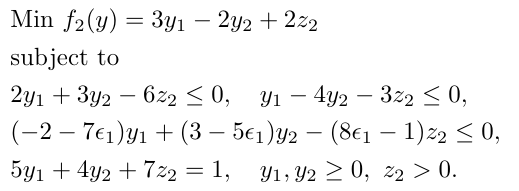
Table 3. Solution of Problem P ∗